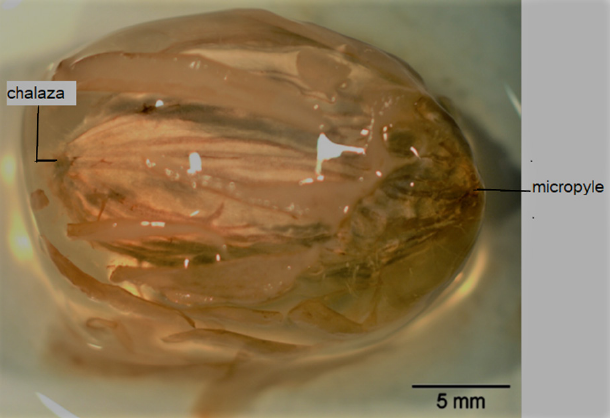
Fig. 8 : Swollen TA-mucilage layer of a depulped cacao seed after 8 hours in water. The micropyle is visible covered by the swollen mucilage layer. Vascular bundles are evident on the surface of the testa. They are not connected to the micropyle. The chalaza is at the opposite end of the seed from the micropyle. Layers from the outer part of the exotesta are also visible. In contrast, when the TA-mucilage of cacao is hydrolyzed, the con- tent of individual amino acids increases considerably (Fig. 9), where- as untreated TA-mucilage contains only small amounts of free amino acids. The most abundant amino acids are glutamic acid, lysine and aspartic acid. Glutamine, histidine, and tryptophan were present